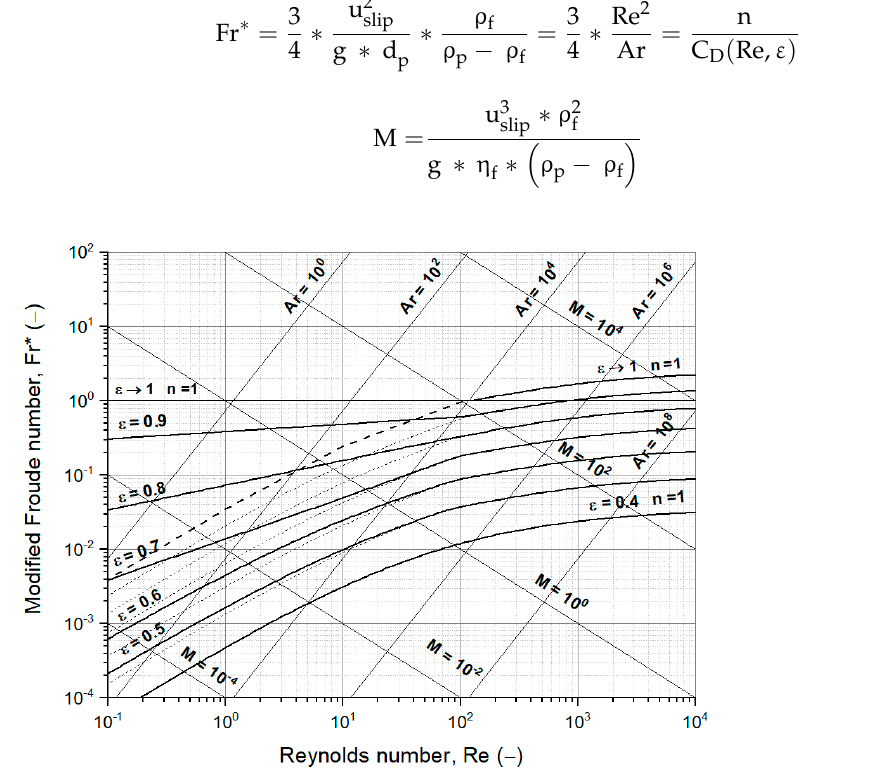
Figure 4. Fluidized state diagram following Reh with the extended area of fluidized beds for small particles from homogenous fluidization [43], dashed lines, to heterogenous fluidization, solid lines. Besides Reh’s fluidized state diagram, similar diagrams to characterize the fluidization are given by the fluidization regime map of Grace or by the flow regime diagram of Rabinovich and Kalman or Shaul et al. [44–47]. Compared to the fluidized state diagram following Reh, only the area for homogenous fluidization is drawn, which means no considerations for the heterogenous fluidization are taken into account. However, some boundaries for different fluidization regimes are drawn based on empirically determined equations. Another difference is that the lower limit for the fluidized bed area is defined by the minimum fluidization velocity but based on simplified equations and thus only limited to iron ore ultra-fines. Shaul et al. also considered the bed height to diameter ratio for the flow regime diagram [45,46]. In addition, they also established a block-flow diagram to determine regimes for fluidized beds regarding the defined groups of Geldart, but without Group C and including the bed height to diameter ratio [45]. 4. Influence of the Reduction Process on the Fluidization Behavior The operating temperature of a reduction process for iron ore is well above ambient, and has different gas mixtures and elevated pressures. Several authors have evaluated diverse affecting variables accounting for particle and gas properties and process conditions for fluidized-bed operation [26,43–45,48,49]. In principle, three aspects have to be addressed, namely the thermodynamic aspect, the kinetic aspect and the need for stable fluidization to ensure an intense contact between the gas and solid. From the point of view of a plant operator of a hydrogen-based fluidized bed direct reduction plant, the following four conditions of the process need to be balanced to comply with the three aspects [5,26]: • Feed material: as fine as possible to avoid kinetic limitations, but as coarse as possible to enable high gas-flow rates;